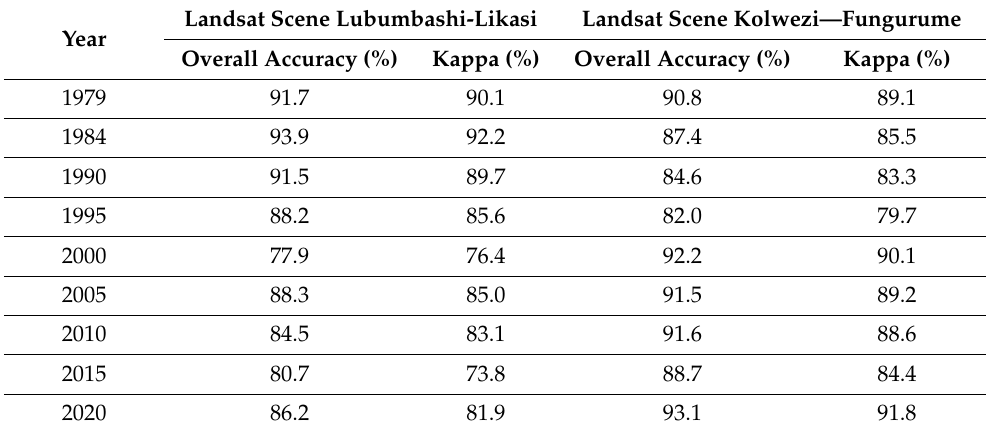
Table 1. Accuracy of supervised classification of Landsat images of 1979, 1984, 1990, 1995, 2000, 2005, 2010, 2015 and 2020 supported by the maximum likelihood